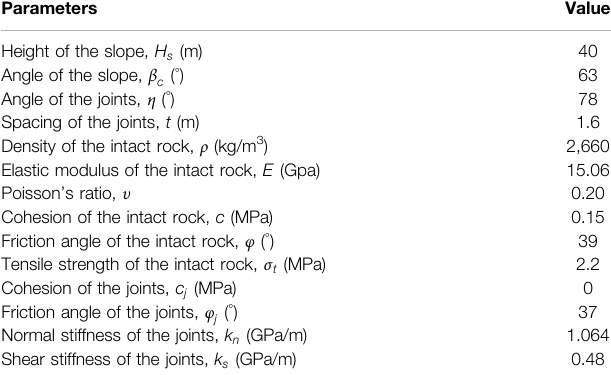
TABLE 1 | Slope parameters used in the numerical